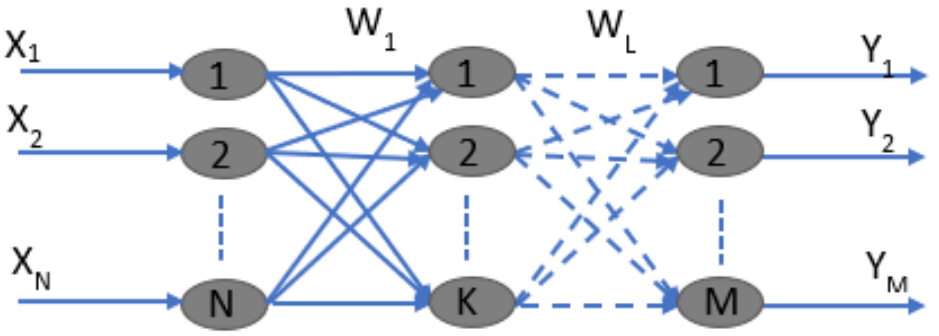
Figure 1. The architecture of an MLP network.